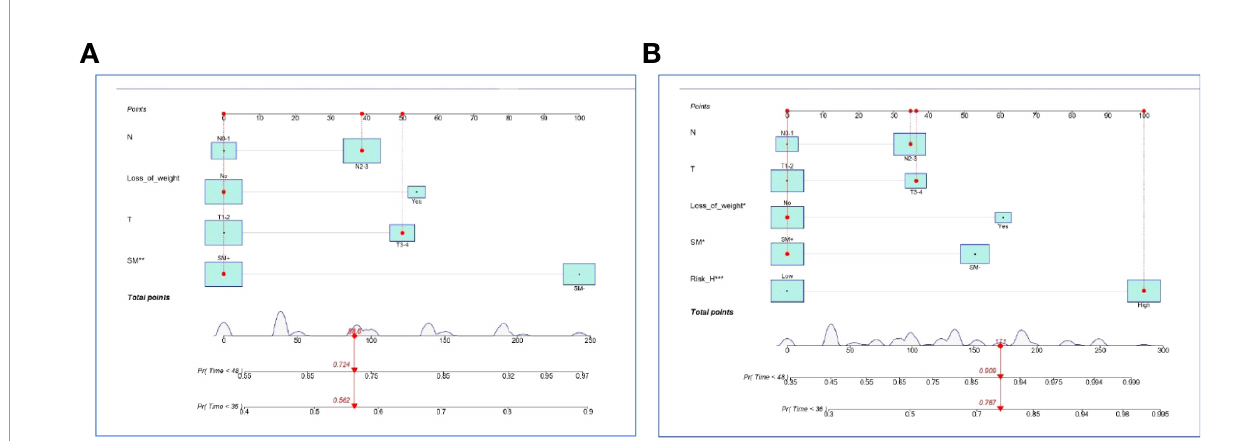
FIGURE 5 | Nomogram models established by clinical variables alone (A) and plus Risk-H (B) in the internal set.